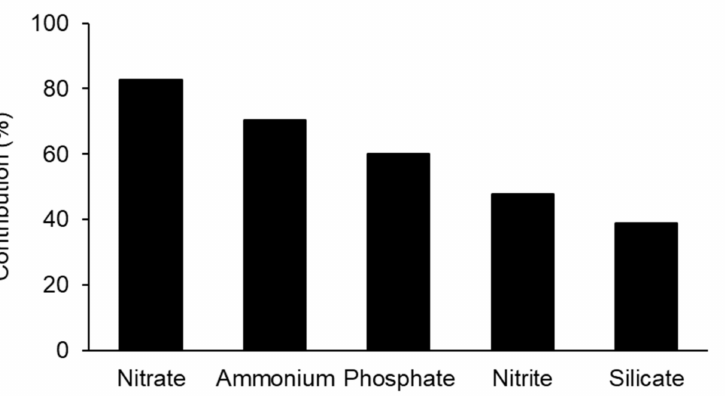
Figure 3. The contribution of the five major nutrient compounds to the Gwangyang Bay ecosystem as determined by principal component